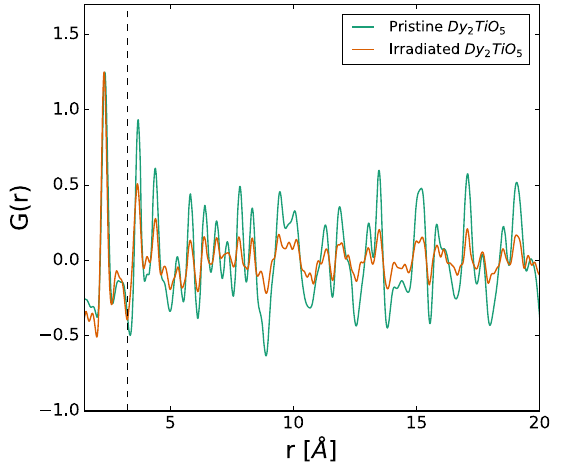
Fig. 5 Neutron pair distribution function (PDF) for pristine and irradiated Dy 2 TiO 5 and Dy 2 Ti 2 O 7 . a Only subtle changes are evident in the PDF of Dy 2 TiO 5 after ion irradiation, most notable at ~3.5 Å corresponding to the negative Dy-Ti correlation and